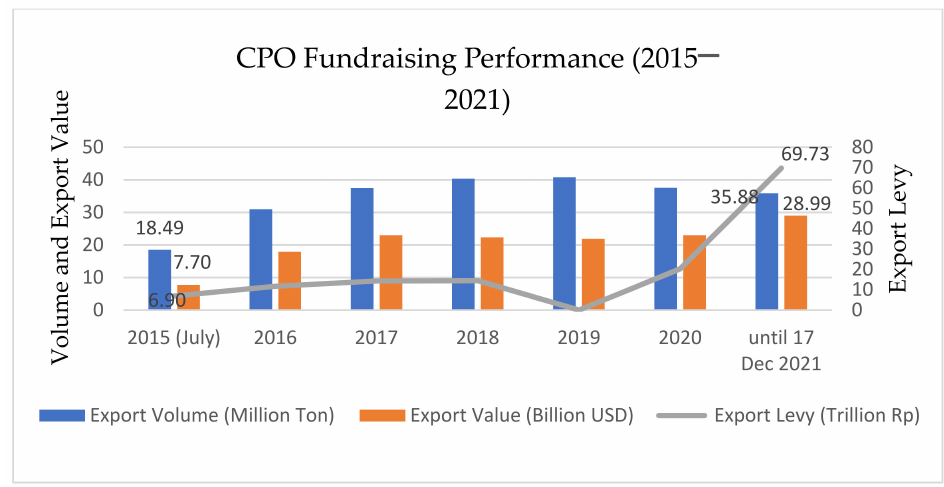
Figure 5. CPO fundraising performance 2015–2021 (BPDPKS)